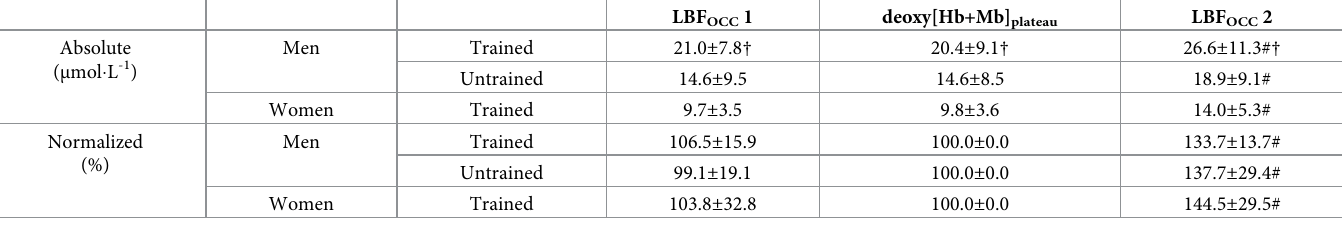
Table 2. Amplitude of the deoxygenated hemoglobin (deoxy[Hb+Mb]) values during the leg blood flow occlusions (LBF OCC 1 and 2) and at the deoxy[Hb+Mb] pla- teau (deoxy[Hb+Mb] PLATEAU ) for all groups. Normalized values are expressed as a percentage relative to the deoxy[Hb+Mb] amplitude from baseline 1 to the deoxy[Hb +Mb] PLATEAU